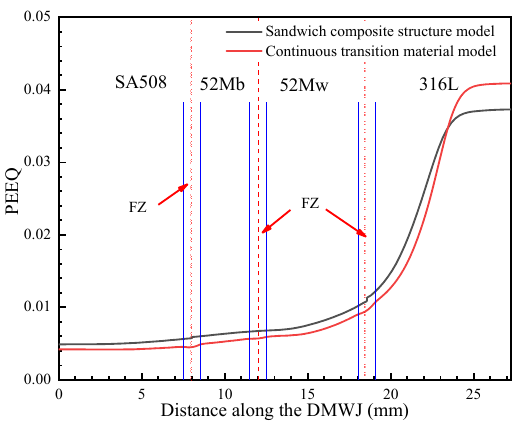
Figure 14. PEEQ along the DMWJ under an axial load.